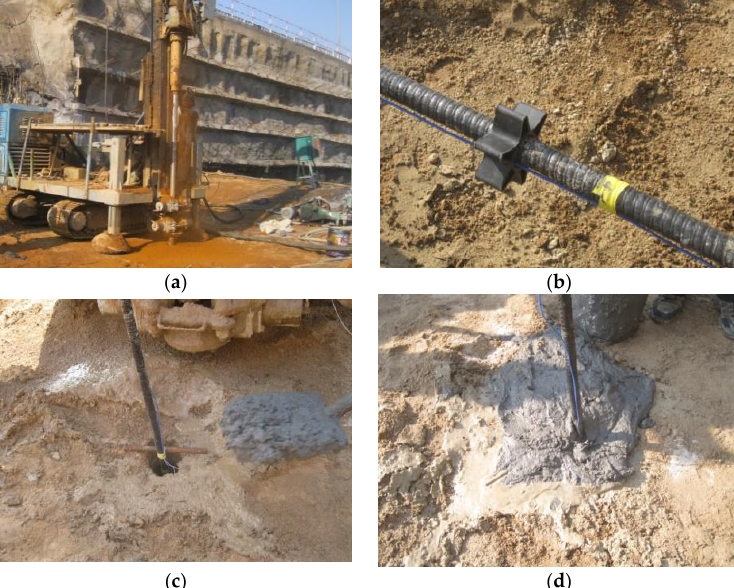
Figure 3. Installation procedure for GFRP anchors: ( a ) drilling hole; ( b ) centering; ( c ) installing; and ( d ) pouring cement mortar.